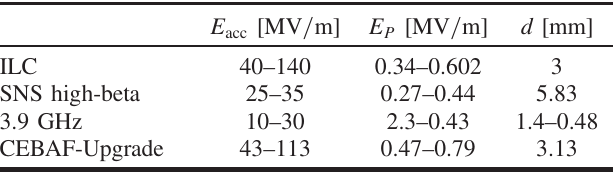
is the acc TABLE IV. Summary of the local peak electric field E p and local gap d of zone 3 MP in HOM couplers of different real cavities. E is the corresponding acceleration acc